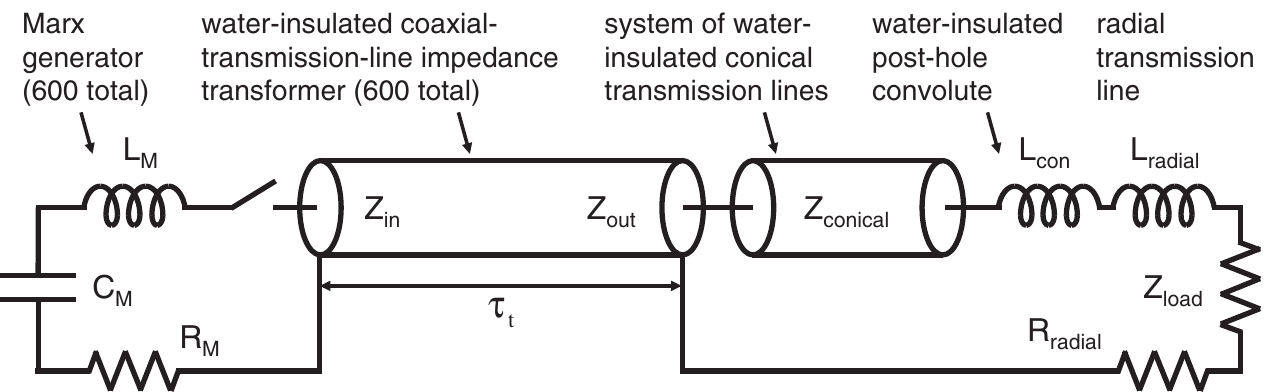
FIG. 5. Circuit model of the Neptune accelerator. The quantities L , C , and R are the series inductance, capacitance, and M M M resistance, respectively, of a single Marx generator; Z and Z are the input and output impedances, respectively, of a single water- in out insulated coaxial-transmission-line impedance transformer; Z is the impedance of the system of twelve parallel water-insulated conical conical transmission lines; L is the inductance of the water-insulated post-hole convolute; L is the initial inductance of the solid- con radial dielectric-insulated radial transmission line; Z is the load impedance (which in this article is assumed to be constant); and R is a load radial resistive circuit element that models the time-dependent energy loss to the two radial-transmission-line